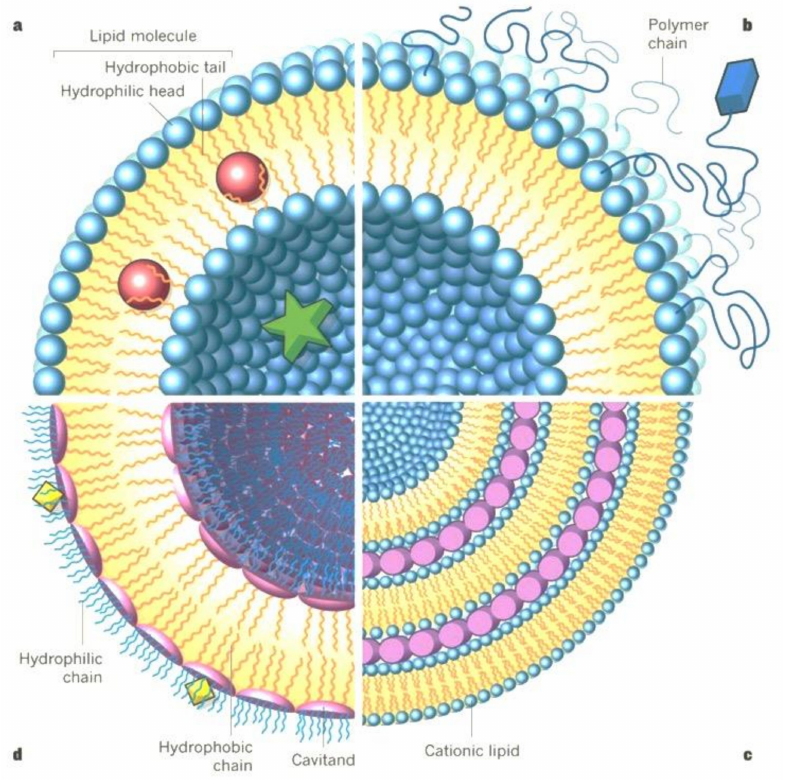
Figure 2. Schematic structure of liposomes showing different compositions. [70]. CC BY 4.0